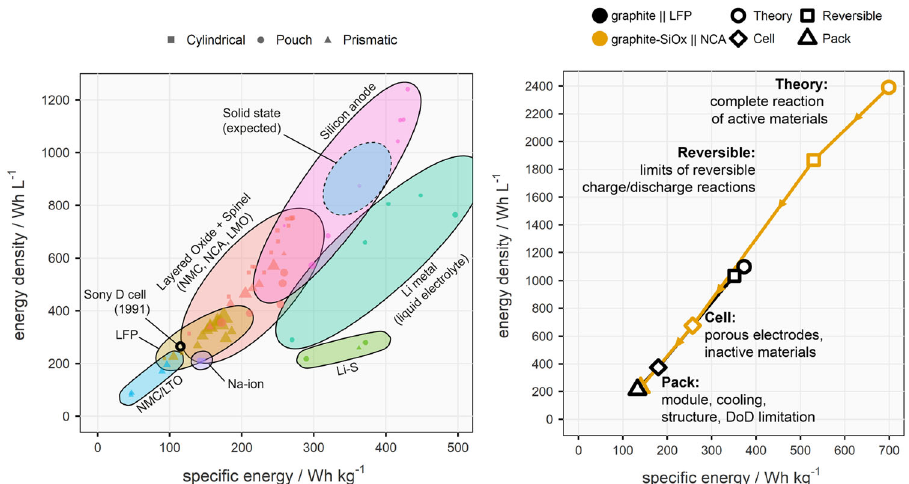
Fig.3|Visualrepresentationoftherangeofenergycontentofdifferentbattery technologies at the cell level and energy losses between theory and system level. Left) energy density vs speci fi c energy for selected Li-ion and “ post-Li-ion ” cells from publicly available speci fi cations; right) schematic of the reduction in energy on a weight and volume basis between the theoretical maximum for the active materials and usable pack-level energy density for state-of-the-art NCA and